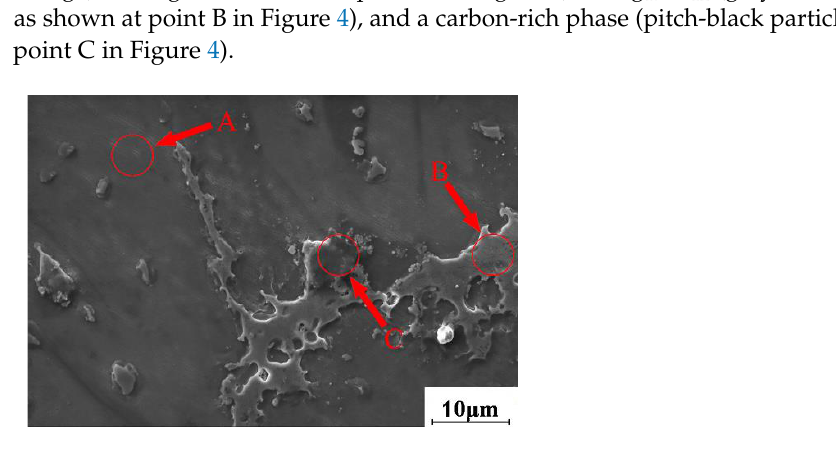
Figure 4. SEM images of 2.0 wt.% Grp/AZ91D. Table 3. EDS results at different positions shown in Figure 4.